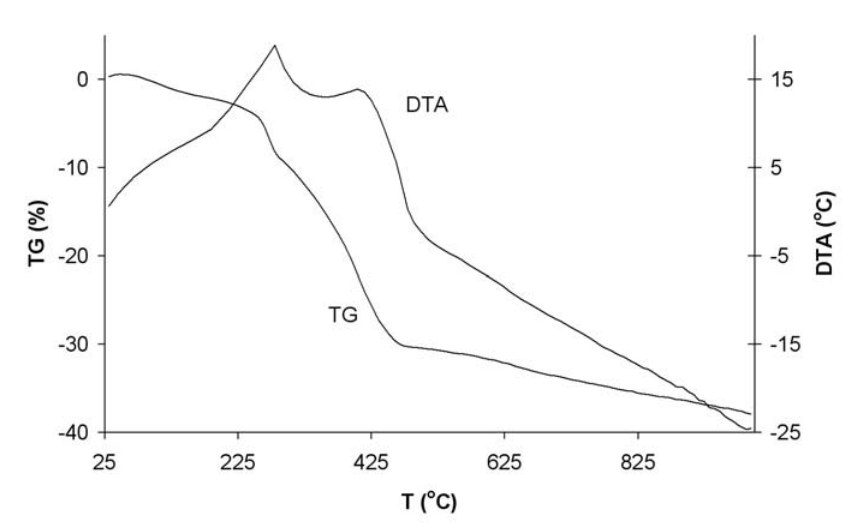
Fig. 2 TG and DTA curves of the Cu,Zn complex immobilised on silica gel by covalent bonds